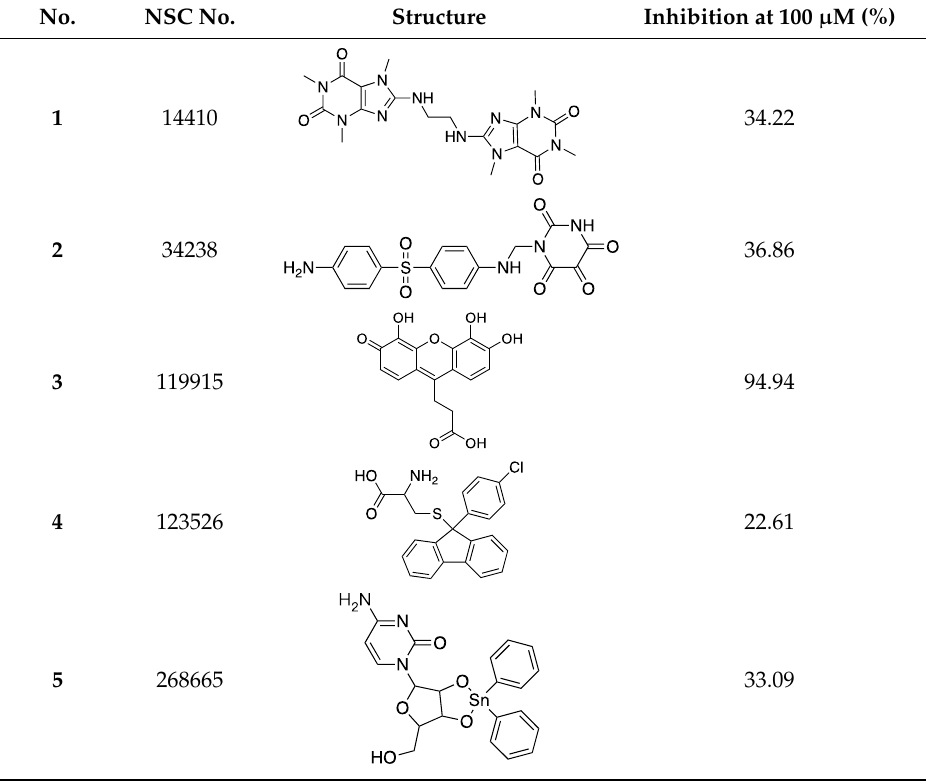
Table 1. The structures and inhibition of five bioactive compounds from the National Cancer Institute (NCI) dataset.